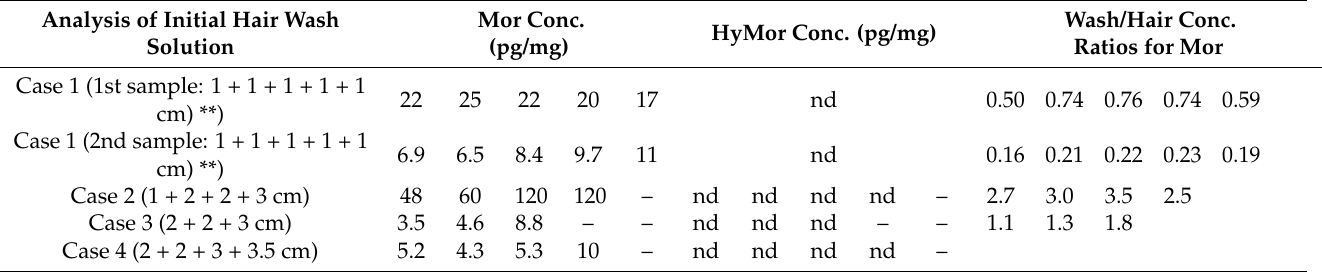
Table 3. Results of the initial hair wash solution testing in morphine intoxication cases